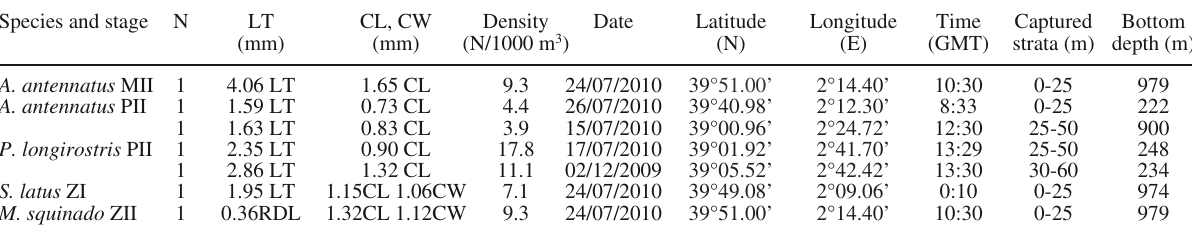
t ablE 1. – Information on number (N), total length (TL), TL zoea of Brachyura (RDL), carapace length (CL), carapace maximum width (CW), densities, date, geographical location, time of day, captured depth stratum and bottom depth for captured larvae of Aristeus antennatus , Parapenaeus longirostris , Scyllarides latus and Maja squinado . Development stages: PII, second protozoea stage; ZI, first zoeal stage; ZII, second zoeal stage; MII, second mysid stage. Species and stage